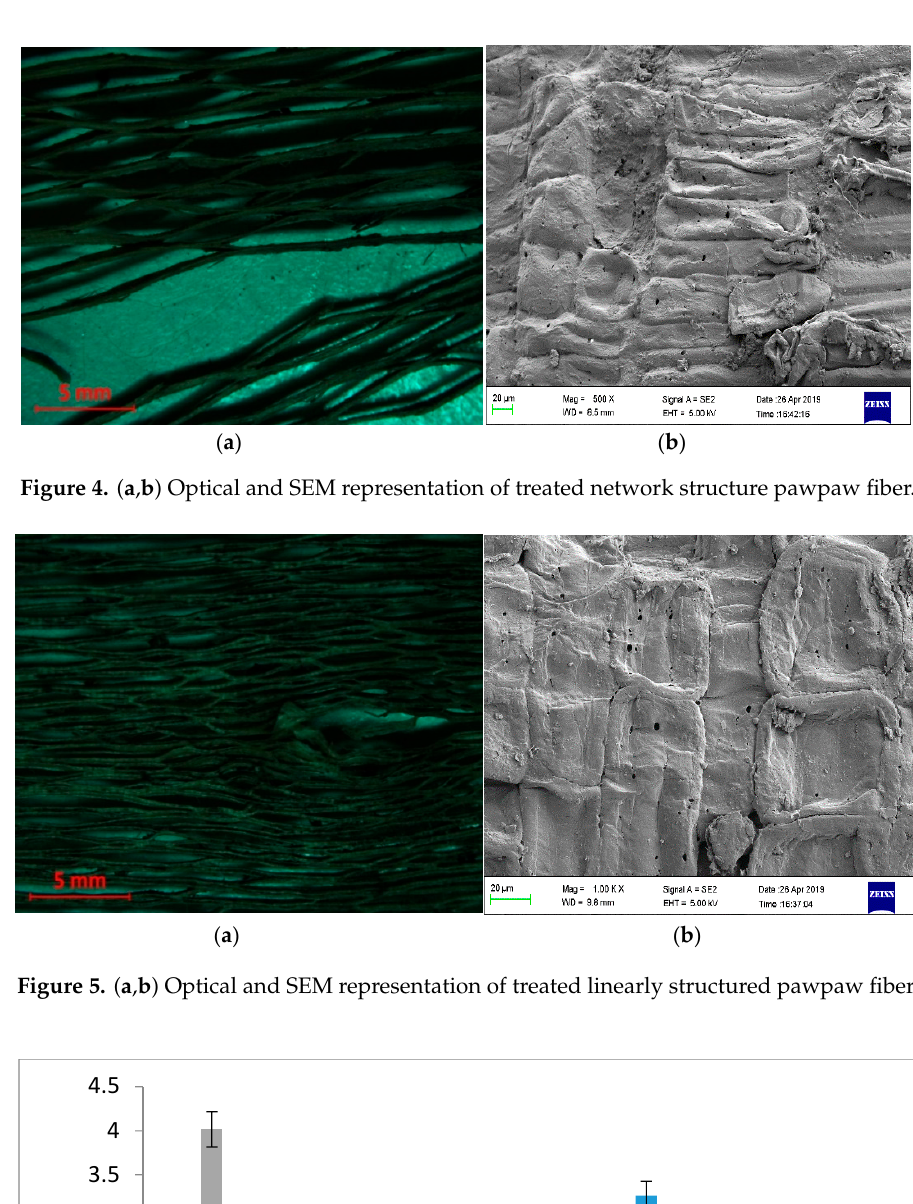
Figure 3. (a , b ) Optical and SEM representation of untreated linearly structured pawpaw fiber.